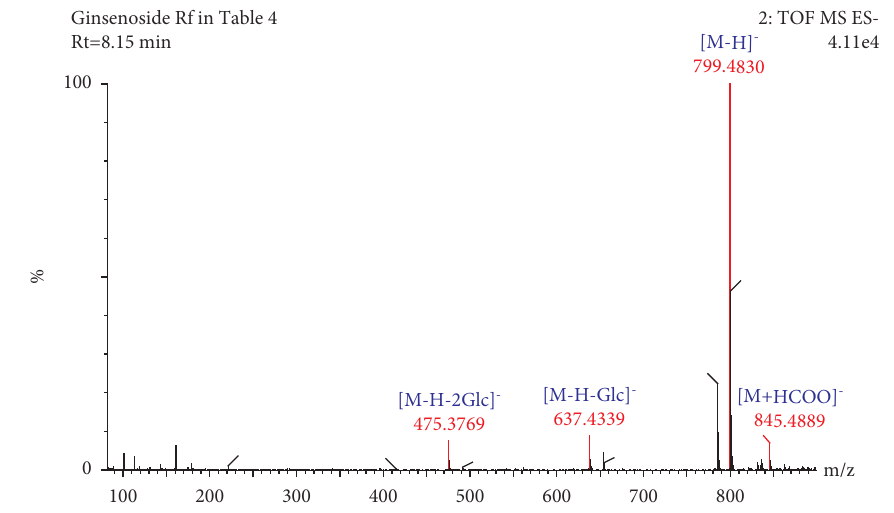
Figure 8: Secondary mass spectrogram of ginsenoside Rf.